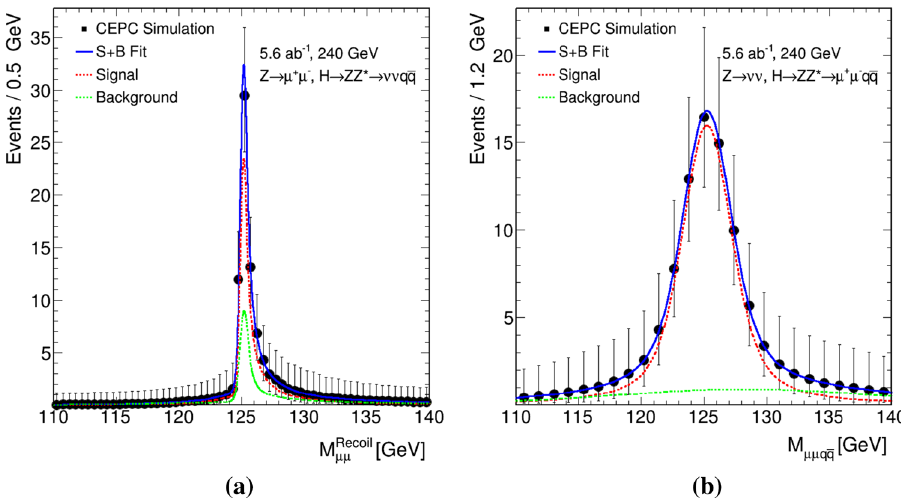
Fig. 3 Recoil mass distributions in the a μμ H νν qq cut and b νν H μμ qq cut categories from the cut-based analysis. The black dots represent the predicted results at the CEPC and the solid blue line shows the fitted model which is broken down into signal (dashed red line) and background (dashed green line)